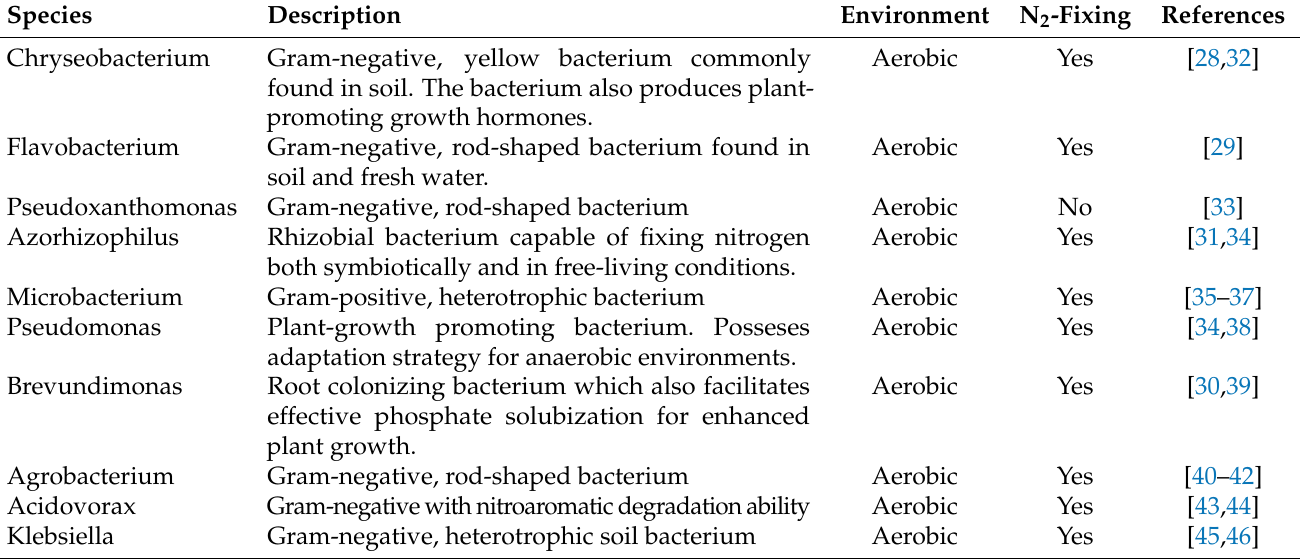
Table 3. Summary of most prominent bacteria species in the experimental